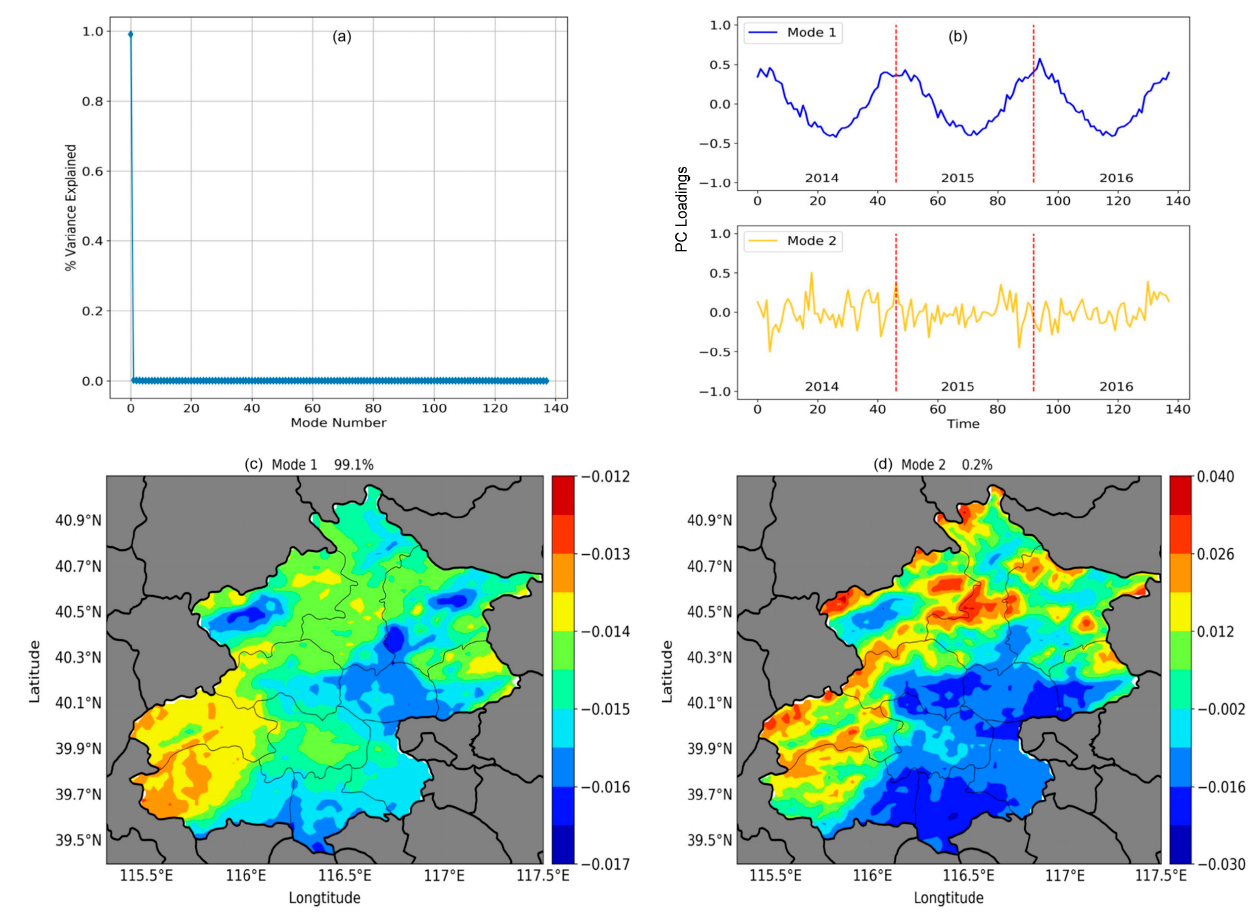
Figure 4. The S-mode PCA results for Beijing surface temperature data during 2014–2016: ( a ) the variance explained by the principal covariance analysis (PCA) modes for surface temperature; ( b ) the PC time series of the first two modes (the red vertical lines are used to divide data into different years); ( c , d ) the spatial patterns of the first two modes for the PCA results.